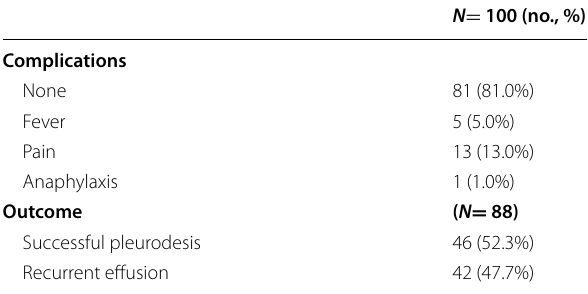
Table 9 Outcome among studied